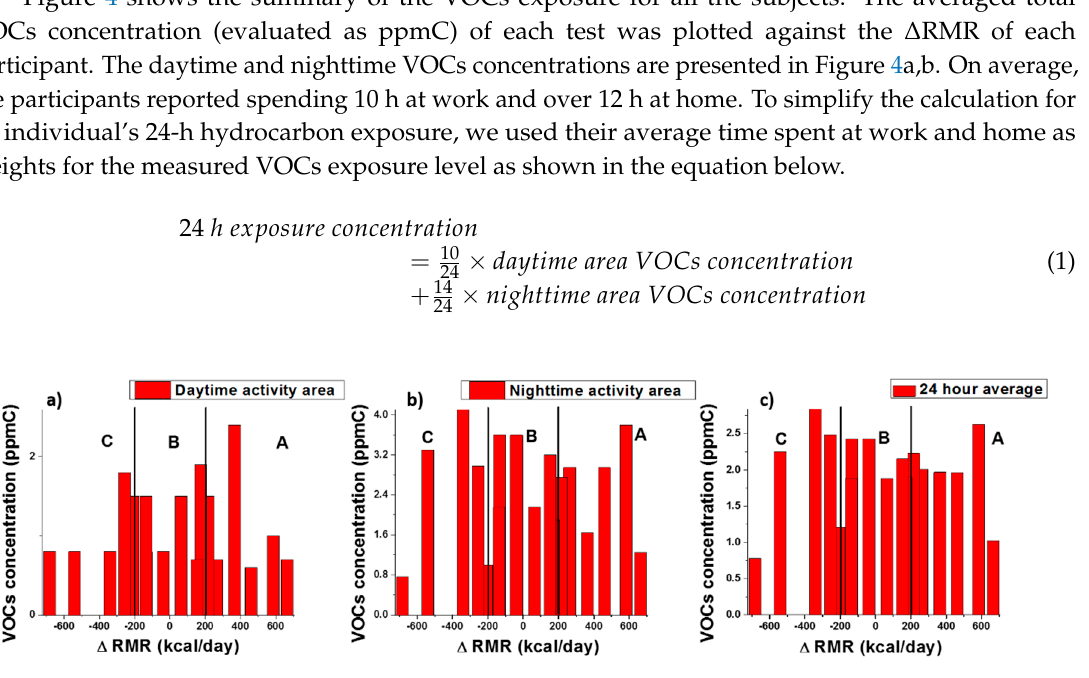
Figure 4. Average VOCs concentration for each test: ( a ) participants’ work area; ( b ) participants’ home; ( c ) prediction of 24-h exposure level by applying the average time spent in each location. A, B, and C indicate the group of participants with low, normal, and high RMR, respectively.